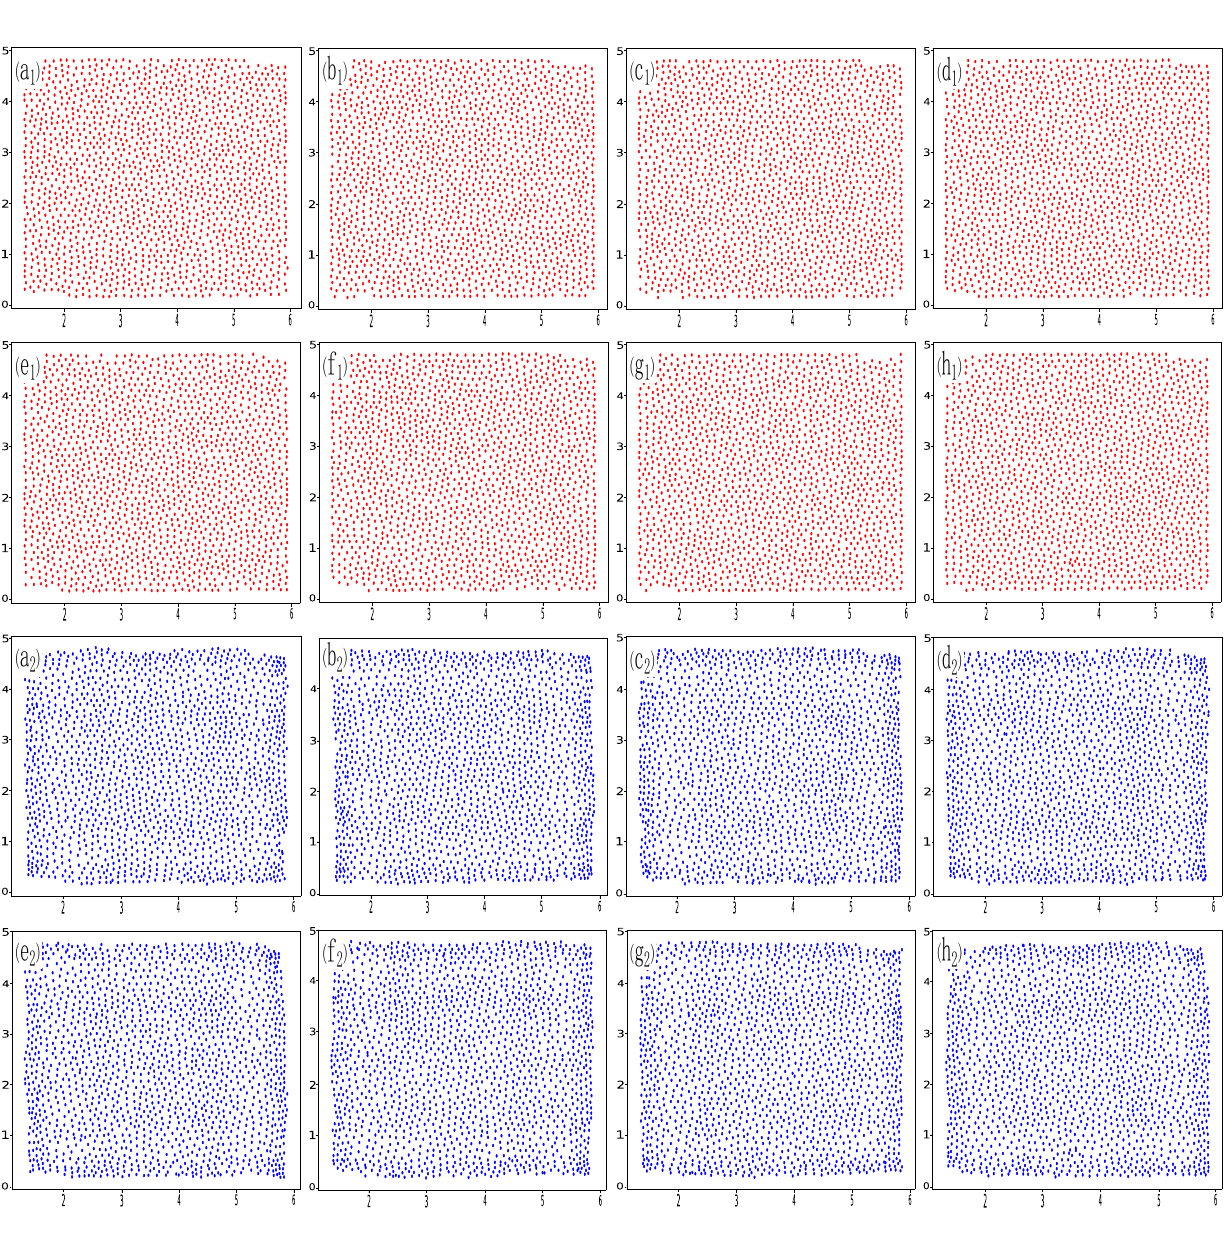
Figure A1. Granular system coordinate diagram and coordinate prediction diagram. ( a 1 – h 1 ) Coordinate diagram of granular system with eight different configurations (conf1, conf2, conf4–conf7, conf9,